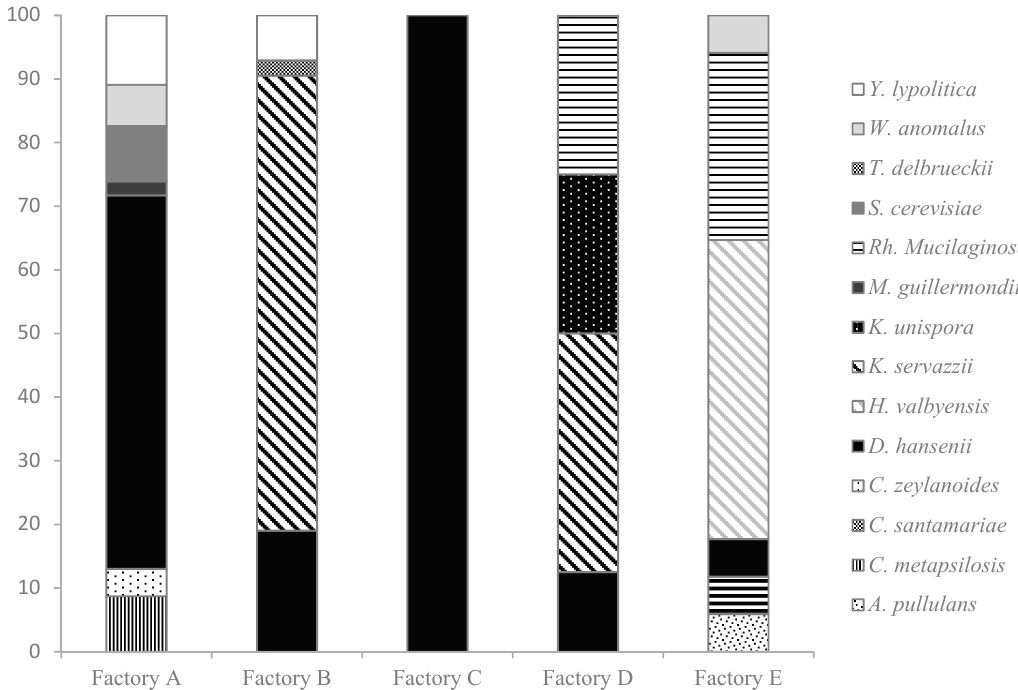
Figure 2. Distribution (%) of the yeast species found in the different curing rooms studied. Factories A and B: Pork meat products and C–E game meat products.